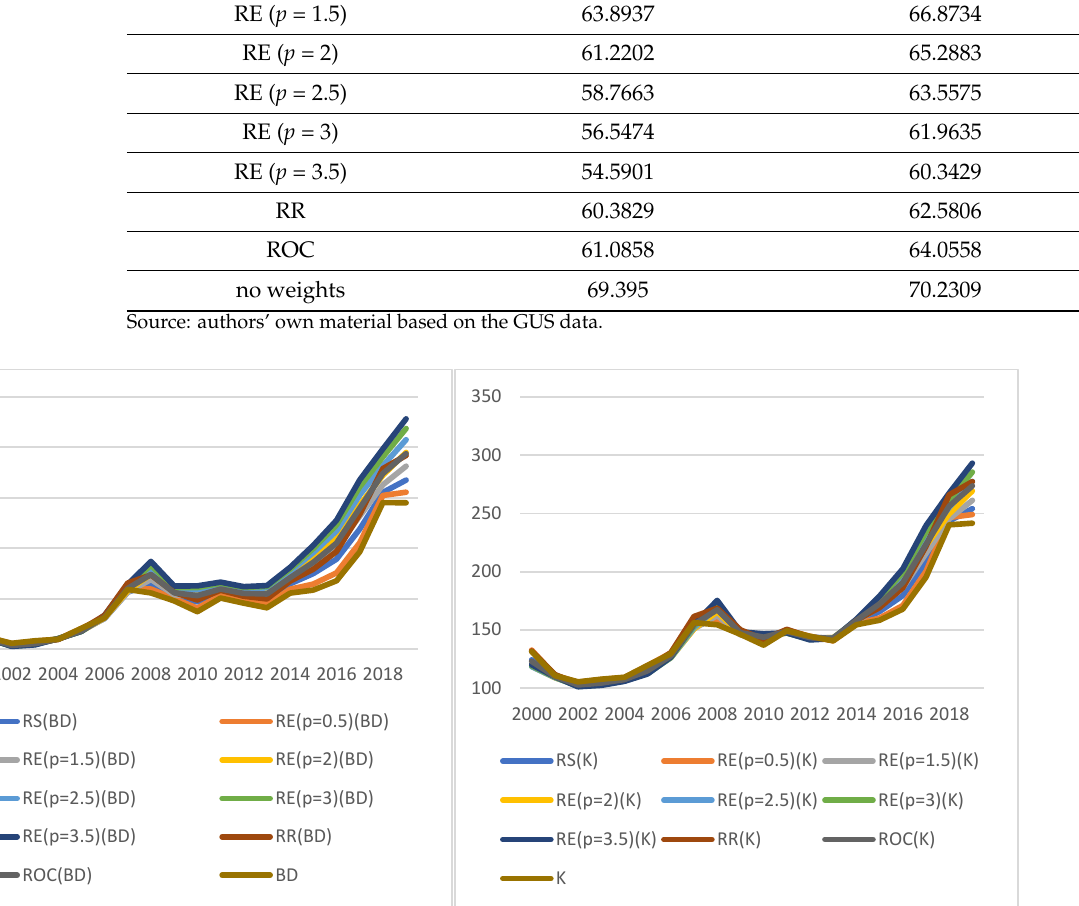
). Source: authors’ own material based on worst